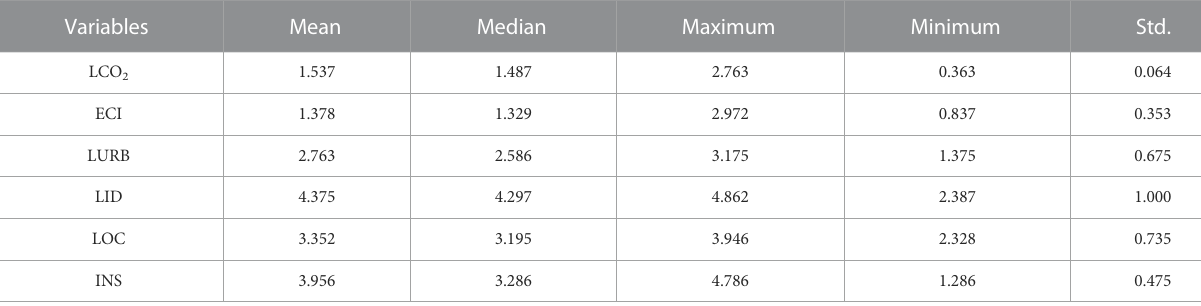
TABLE 2 Descriptive